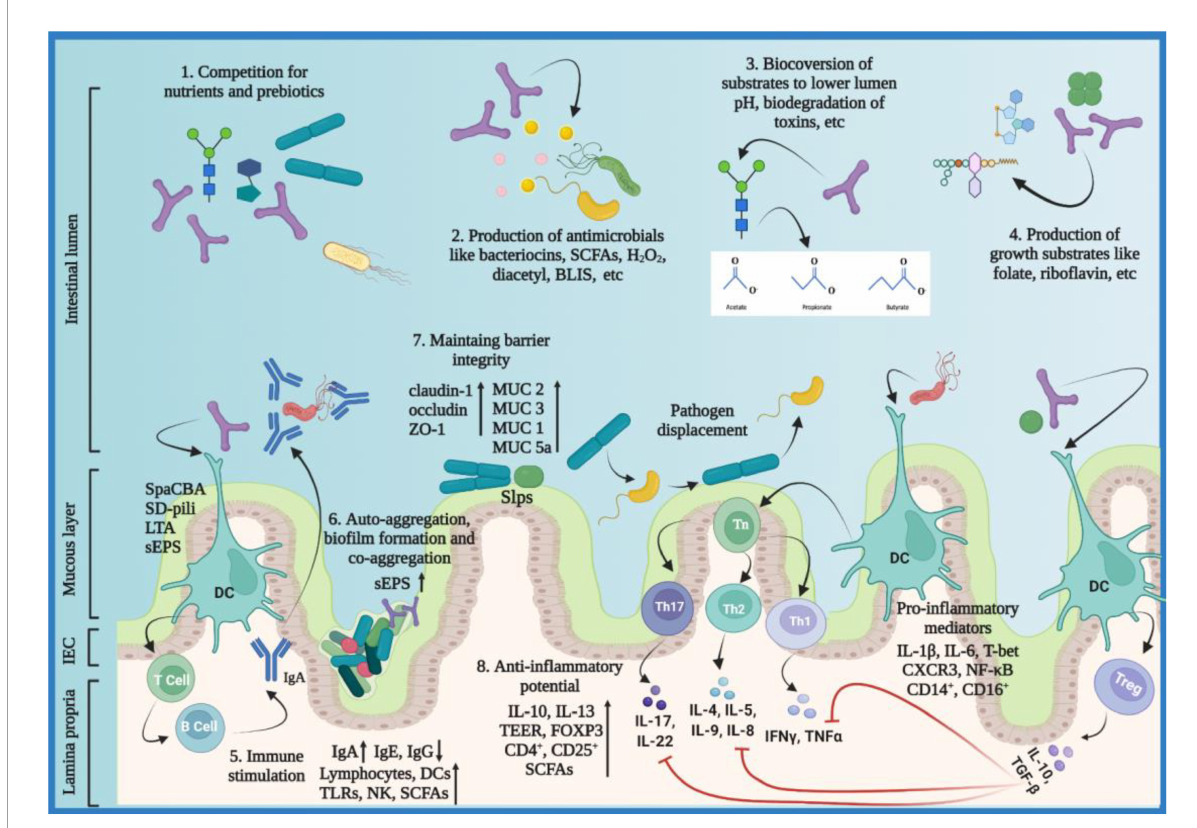
FIGURE2 Probiotics action modality. Probiotics employ various mechanisms to exert their beneficial effects on the host including: (1) probiotics compete pathobionts and pathogens for microbial resources needed for growth and metabolism, e.g., acquisition of monosaccharides; (2) probiotics inhibit pathogens by producing antimicrobials, e.g., SCFAs, bacteriocins, antibiotics, microcins, etc.; (3) probiotics metabolize substrates into useful products, e.g., organic acids and volatile fatty acids; (4) probiotics produce growth substrates for beneficial microbiota and the host, e.g., folate and riboflavin; (5) probiotics induce immunomodulatory responses either by direct contact or surface molecules like SpaCBA, SD-pili, LTA, and sEPS; immune stimulation favors elevated expression of IgA and SCFAs in pathogenic infections and decreased expression of IgE and IgG in allegro-inflammatory responses via stimulating DCs, TLRs, NK cells, and lymphocytes; (6) sEPS facilitate probiotics to auto-aggregate and form protective biofilms and, co-aggregate with pathogens to prevent them from colonizing the host epithelial surfaces; (7) probiotics maintain barrier integrity by regulating TJ proteins (claudin-1, occludin, ZO-1) and by mucus formation via elevated expression of MUC 1,2,3 and 5a; Slps facilitate attachment of the probiotic strains to the gut epithelium; the colonization of pathogens is inhibited through pathogen displacement; (8) probiotics reduce inflammation by upregulating anti-inflammatory and downregulating pro-inflammatory mediators; CXCR3, C-X-C Motif Chemokine Receptor 3; BLIS, bacteriocin-like inhibitory substances; DC, dendritic cell; FOXP3, forkhead box p3; H 2 O 2 , hydrogen peroxide; IFN- γ , interferon-gamma; Ig, immunoglobulin; IL, interleukin; LTA, lipoteichoic acid; MUC, Mucin; NF- κ B, nuclear factor-kappa light chain enhancer of activated B cells; NK, natural killer; SCFA, short chain fatty acids; SD-pili, sortase-dependent pili; sEPS, surface exopolysaccharides; Slps, surface-layer proteins; spaCBA, heterotrimeric pili complex made of protein subunits spa C, spa B and spa A; TEER, trans-epithelial electrical resistance; TGF- β , transforming growth factor-beta; Th, T-helper; TJ, tight junction; TLR, toll-like receptor, TNF- α , Tumor necrosis factor-alpha; Treg, T regulatory. The figure was drawn with